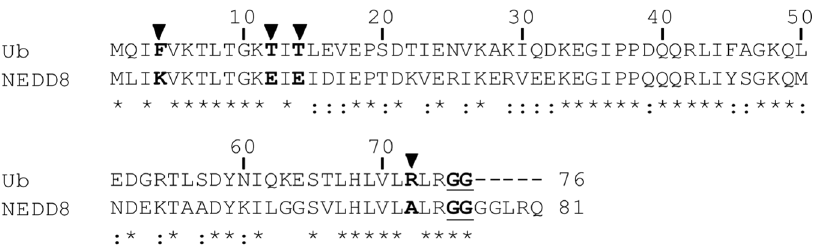
Figure 1. The sequence alignment of human Ub and NEDD8. The amino acid sequences of human Ub and NEDD8 were aligned using ClustalW. Identical residues were marked with asterisks. The non-conserved residues at positions 4, 12, 14, and 72 of Ub and NEDD8 were denoted in bold and marked with solid triangles, where the residues are phenylalanine, threonine, threonine and arginine in Ub and the equivalent residues are lysine, glutamate, glutamate and alanine in NEDD8. The C-terminal di-glycine motif was underlined and denoted in bold.